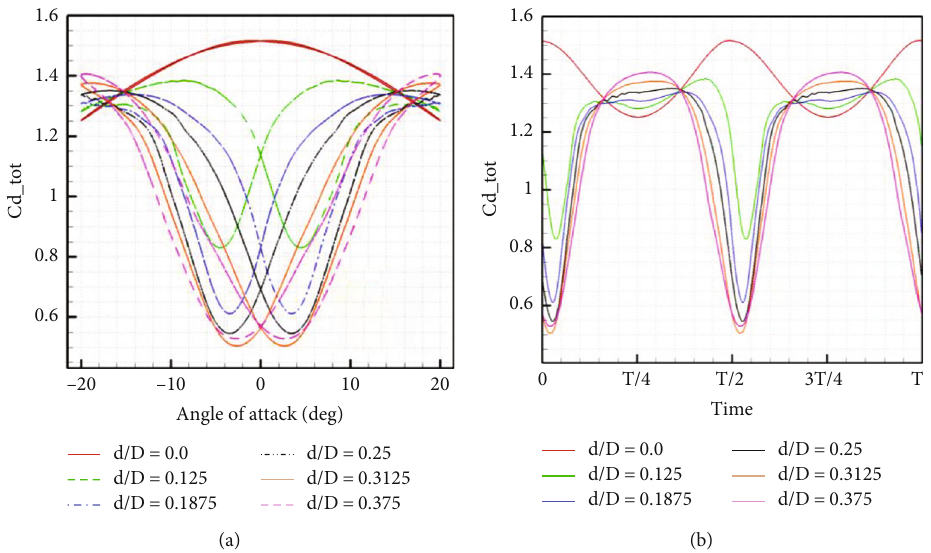
Figure 12: Development of the drag coe ffi cient with di ff erent d / D . (a) Drag coe ffi cients varying with attack angle. (b) Drag coe ffi cients varying with